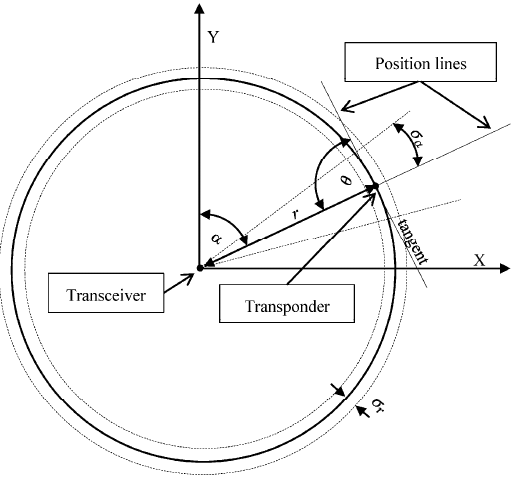
Figure 2. The principle of determining the horizontal coordinates ( x , y ) using USBL